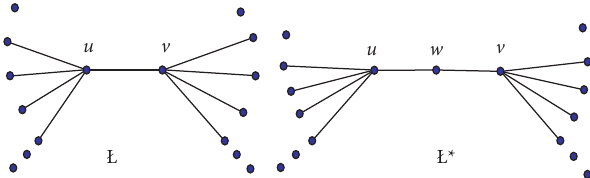
Figure 1: The graphs (a) Ł and (b) Ł ∗ used in auxiliary Lemmas